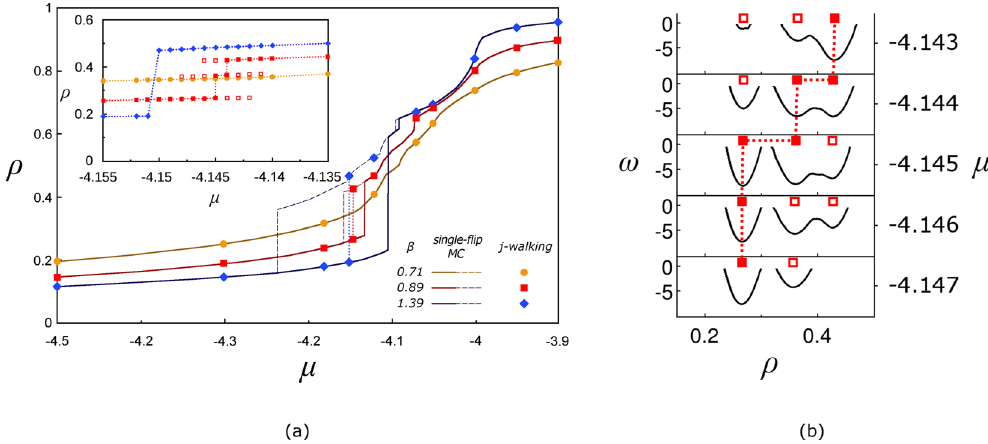
Figure 4. ( a ) The dependence of the mean fluid density ρ in structural model of aerogel versus chemical potential μ for several temperatures as marked in the figure. The results of the single-flip conventional MC simulations for adsorption (increasing μ ) and desorption (decreasing μ ) are shown by solid and dashed lines, respectively. The symbols refer to results of the JW MC simulations. For equilibrium isotherm at β = 0.71, the solid and dashed lines coincide with each other and with the solid circles. The inset shows magnification of the isotherms obtained by the JW MC simulations for the values of μ where the discontinuous transitions occur at low temperatures. The solid (open) symbols correspond to the deepest minimum (other minima) in the grand- potential landscape, ω ( ρ ). ( b ) Grand potential landscapes, ω ( ρ ), for β = 0.89 and several values of μ specified on the right from each panel. The solid and open squares mark the deepest and other minima of ω ( ρ ), respectively, in the same way as in ( a